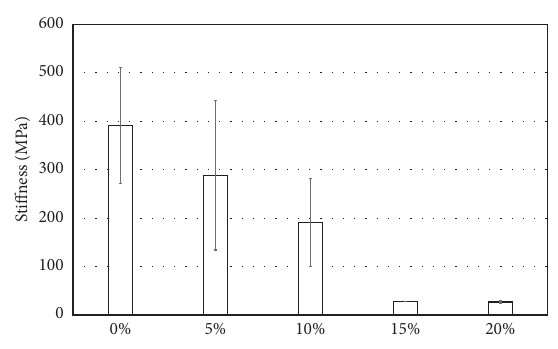
Figure 10: Stiffness of SIS binders at − 24 °